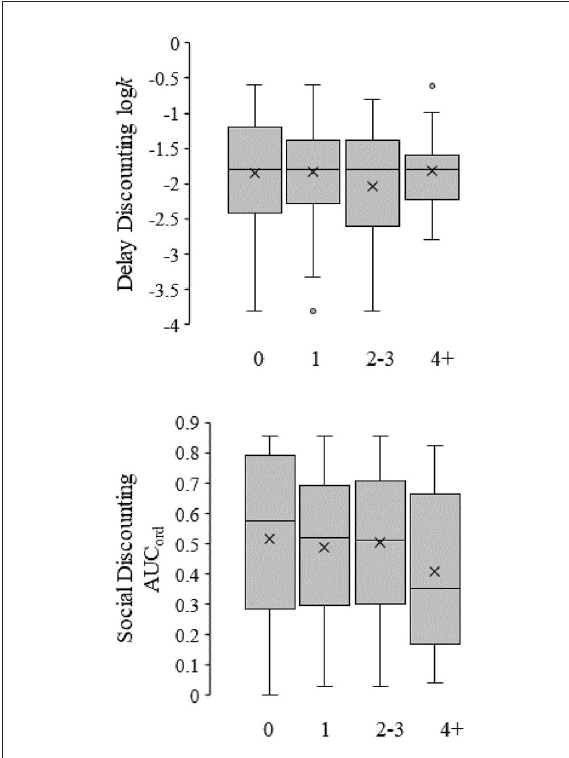
FIGURE2 Box-and-whisker plots for the relationship between delay (top figure) and social discount (bottom figure) rates and alcohol use. Symbols are the same as in Figure 1. The leftmost box represents individuals self-reporting no alcohol use ( n = 115), whereas subsequent boxes represent individuals self-reporting drinks per week in ascending order ( n ’s; 1 = 54, 2–3 = 53, and 4 + = 39).